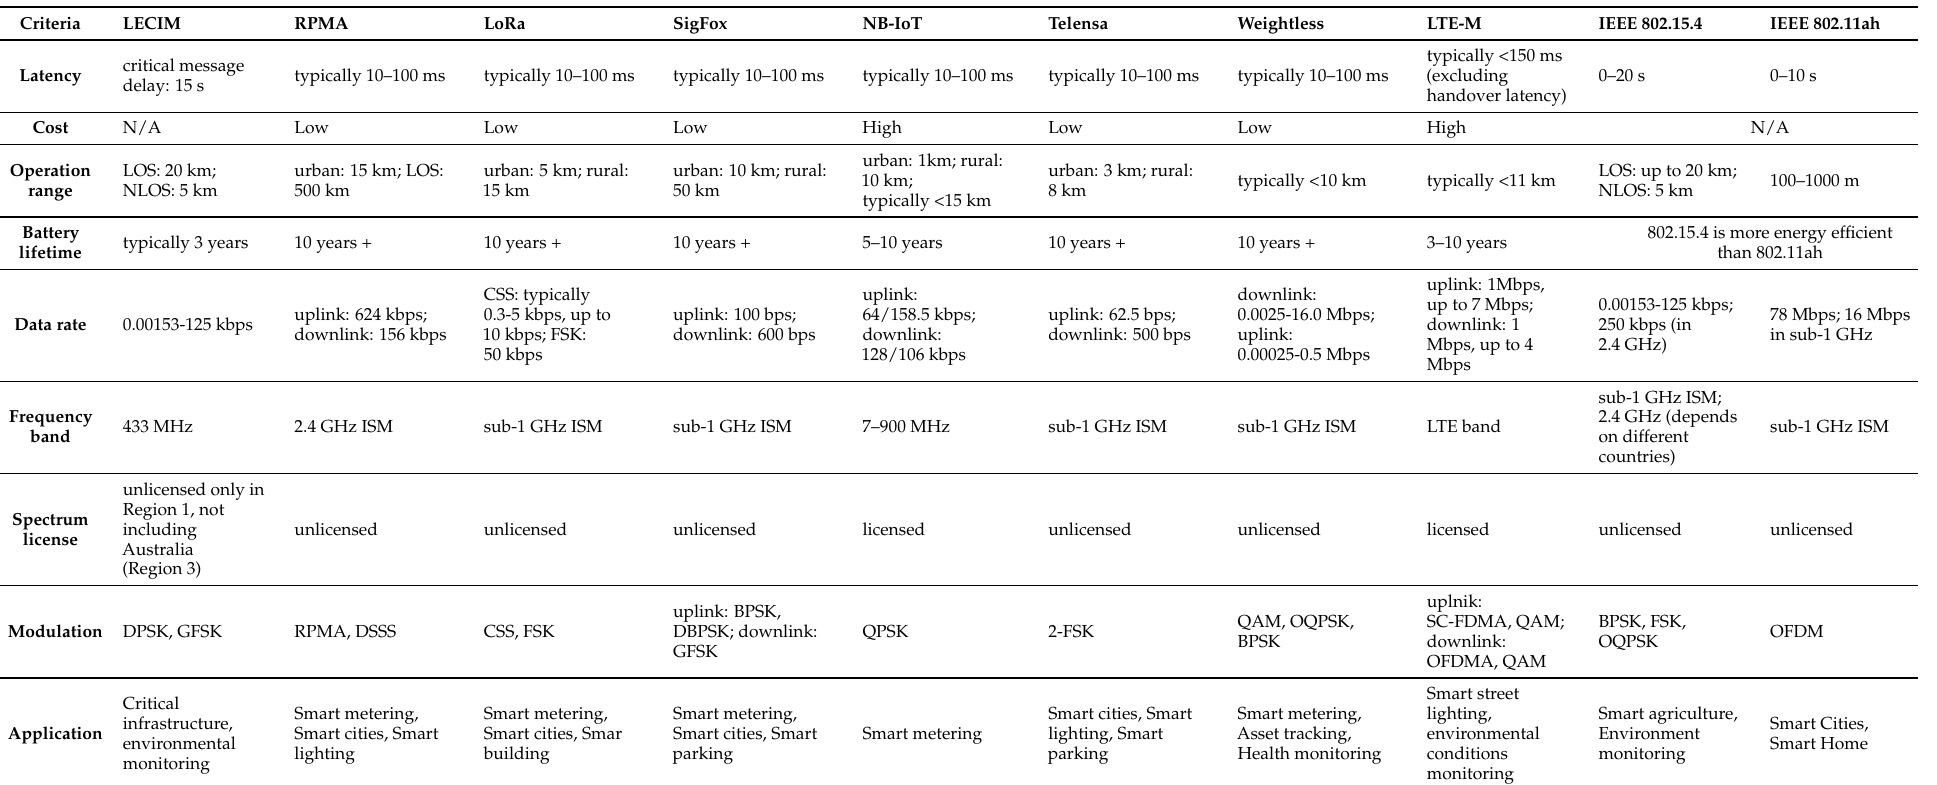
Table 5. Overview and Comparison of LPWA